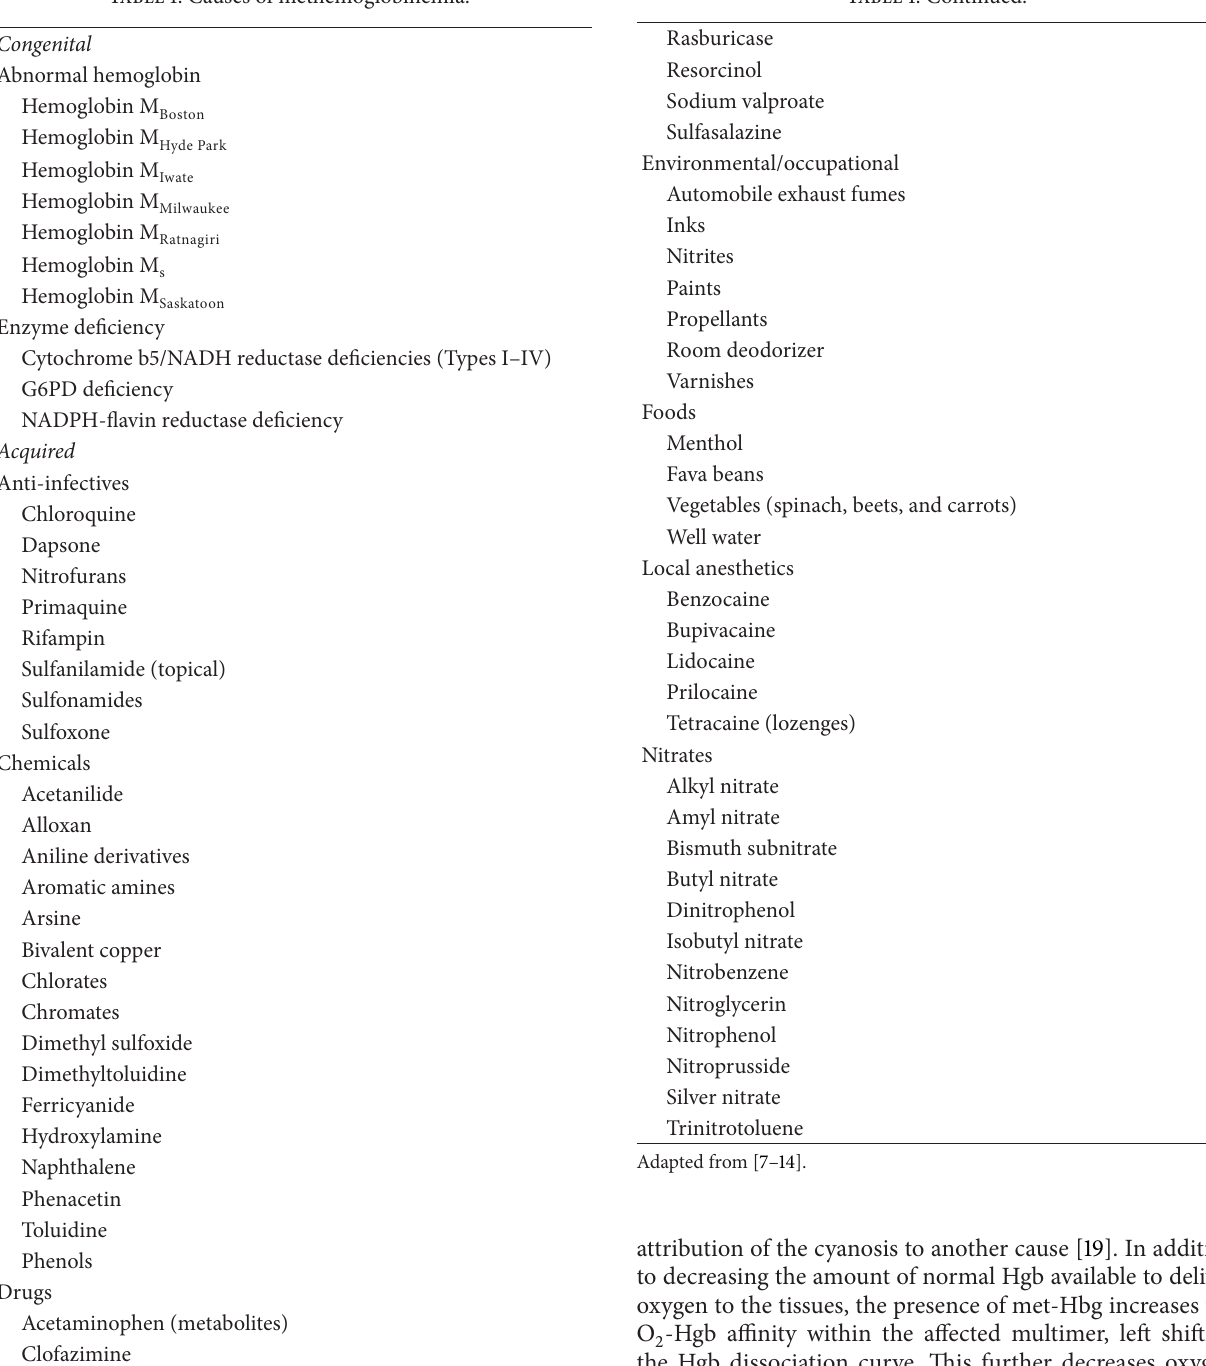
Table 1: Causes of